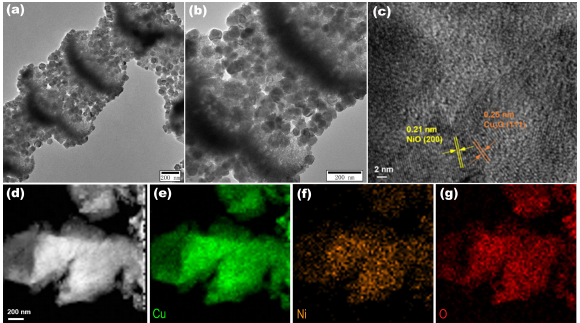
Fig. 3. TEM images of the Cu 2 O/NiO nanoarrays (a) (b) and (d). HRTEM image of the nanoarrays (c). Element mapping of Cu (e), Ni (f), and O (g) corresponding to (d).